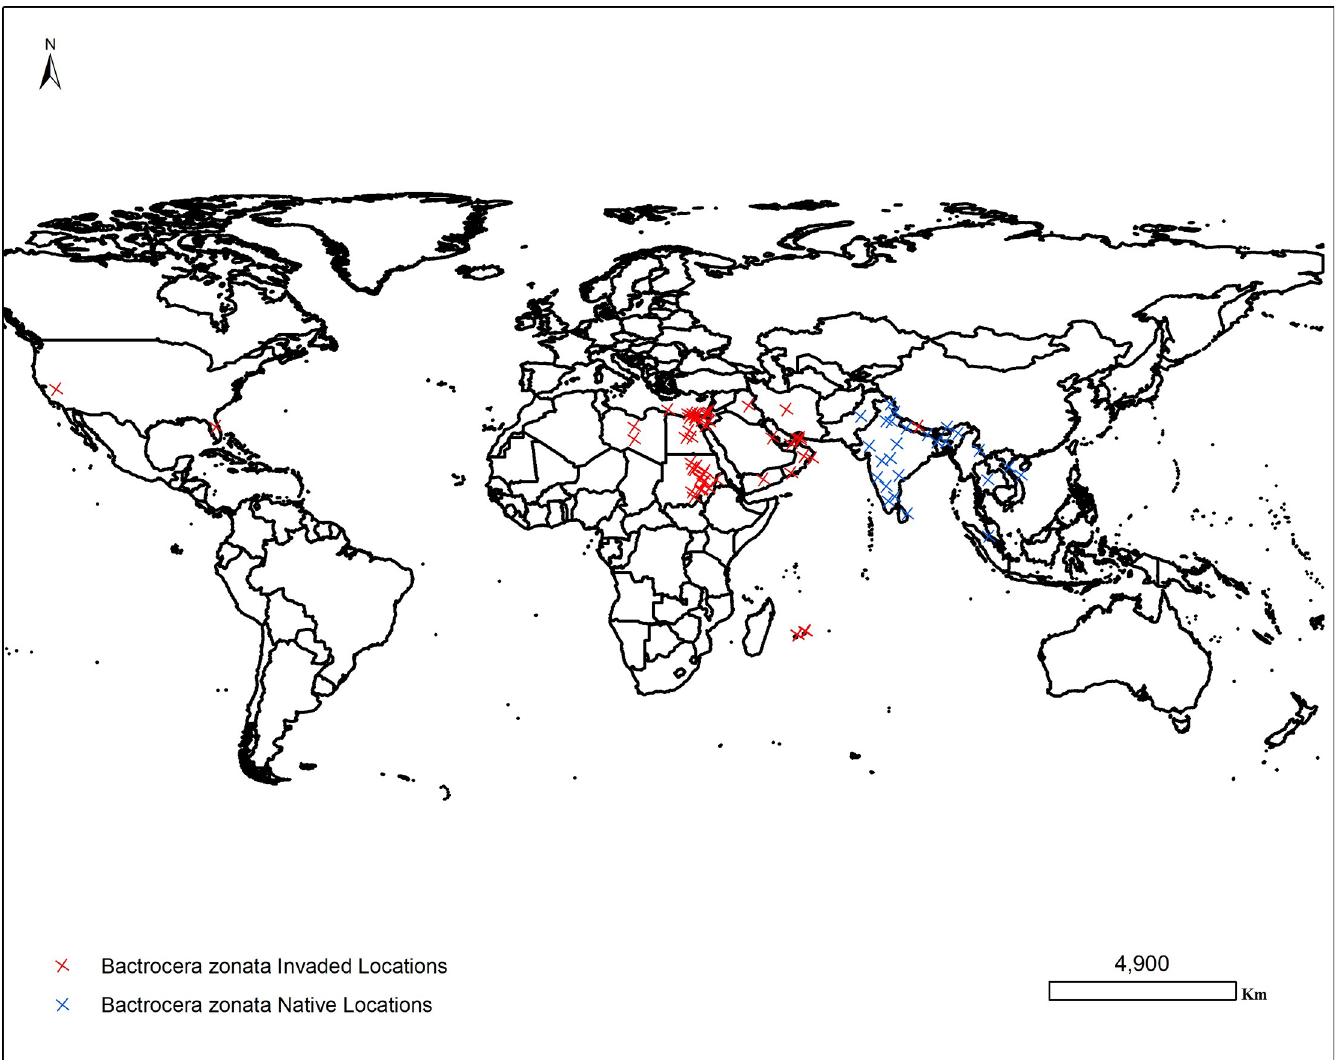
Fig 1. The updated distribution map of the native and invaded occurrence records for Bactrocera Zonata collected from the Centre for Agriculture and Bioscience International (CABI) Invasive Species Compendium datasheet number 17694 (n = 37) [8], the Global Biodiversity Information Facility (GBIF) (n = 7) [48] and published articles (n = 7) [20,49–51]. In Sudan, updated georeferenced occurrence records of B . zonata (n = 57) were obtained from the Agricultural Research Corporation (ARC) of Sudan. “The figure was generated using the QGIS 3.10.2 software